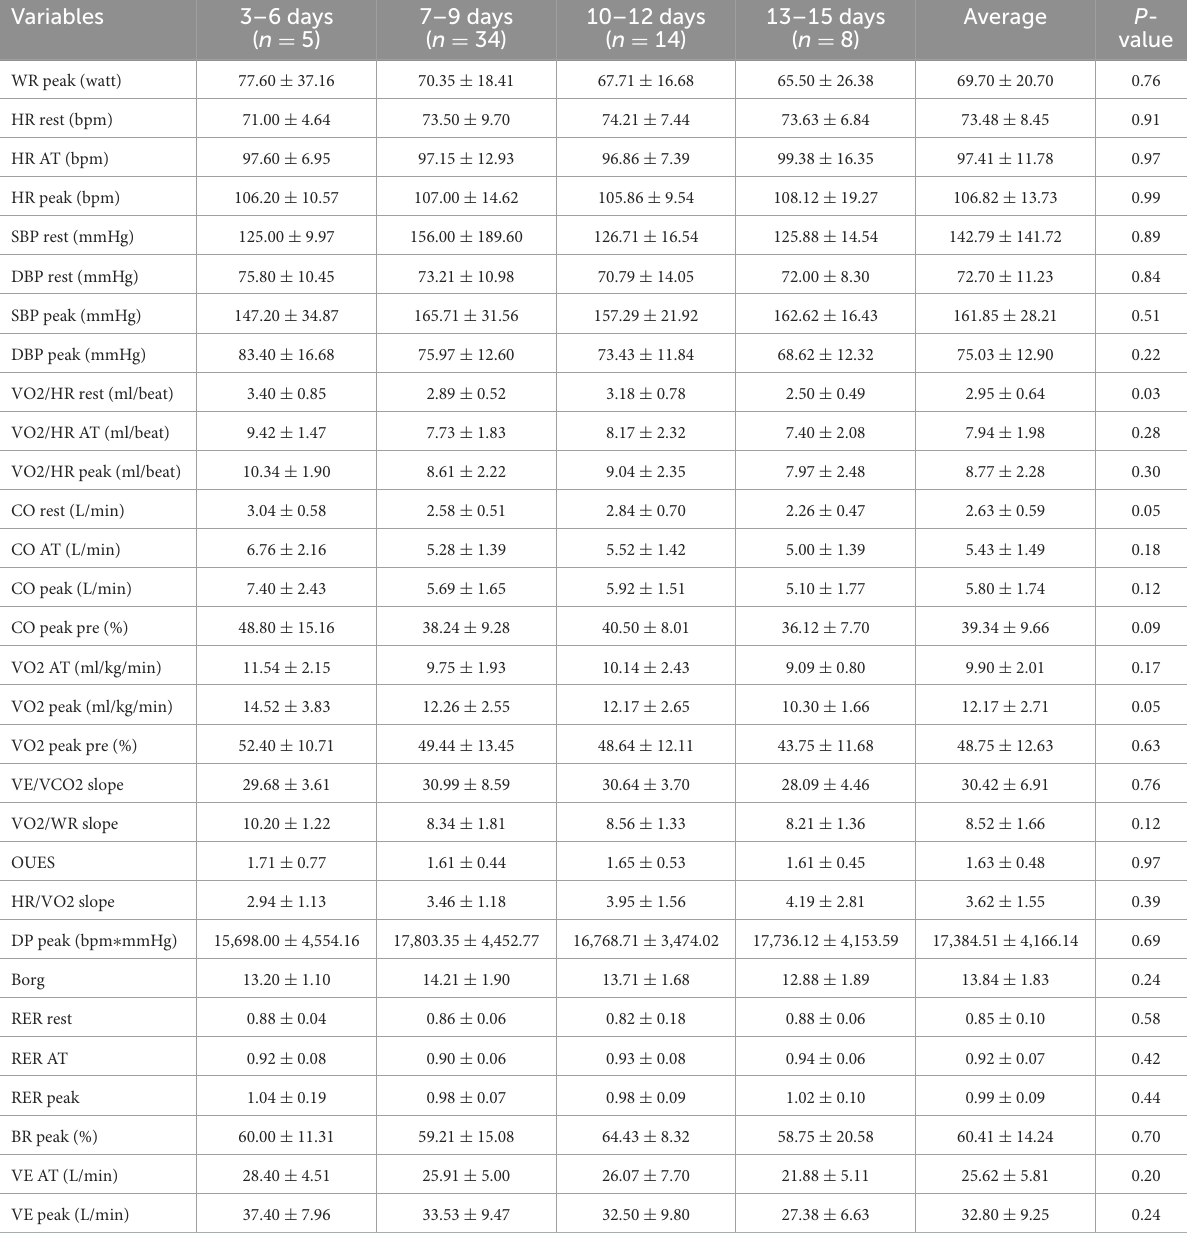
TABLE 2 CPET variables in different